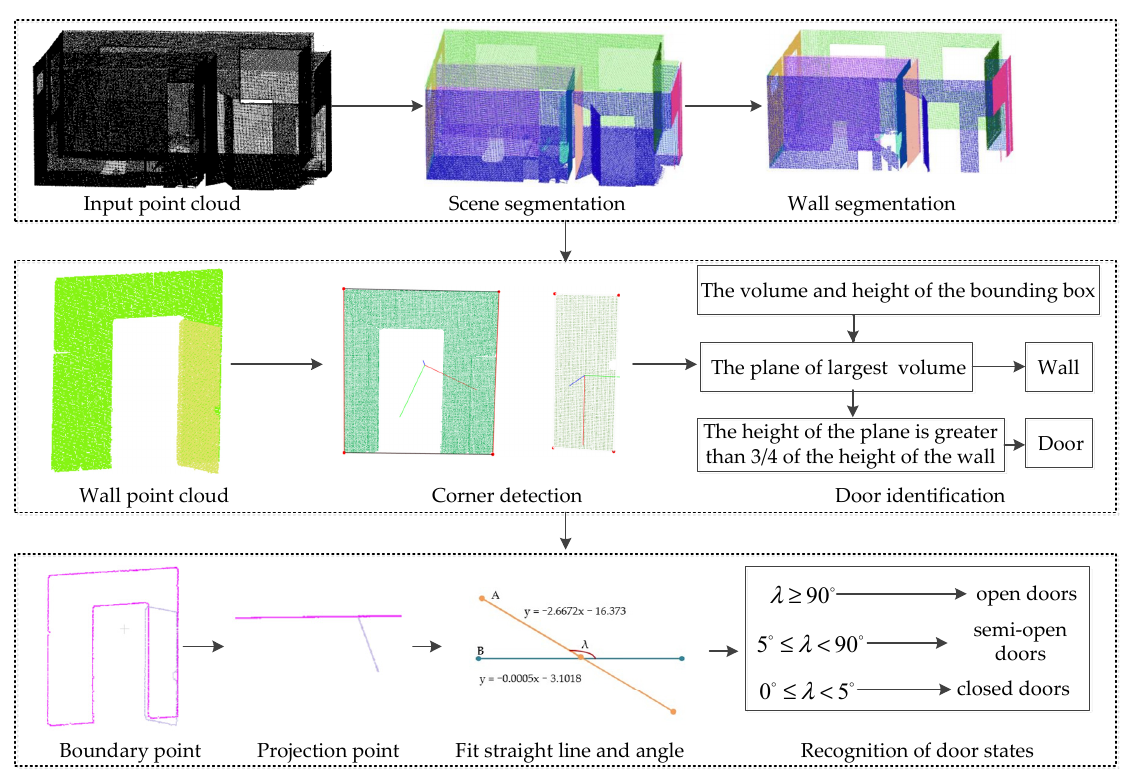
Figure 1. Flowchart of the proposed